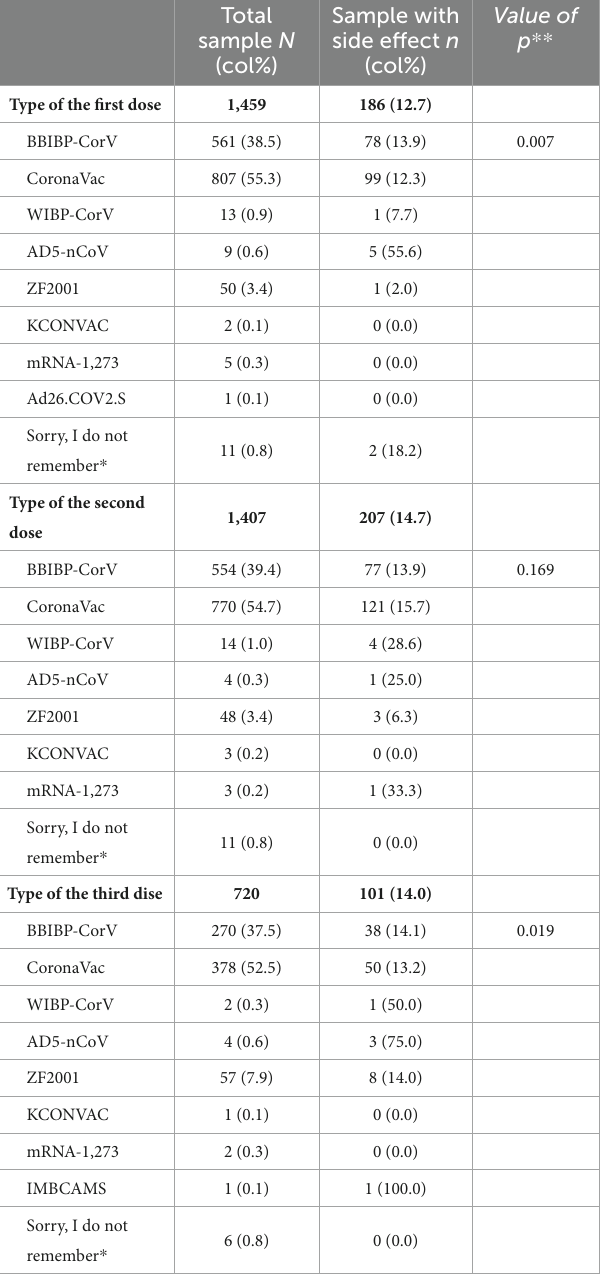
TABLE 3 COVID-19 vaccine type and side effect